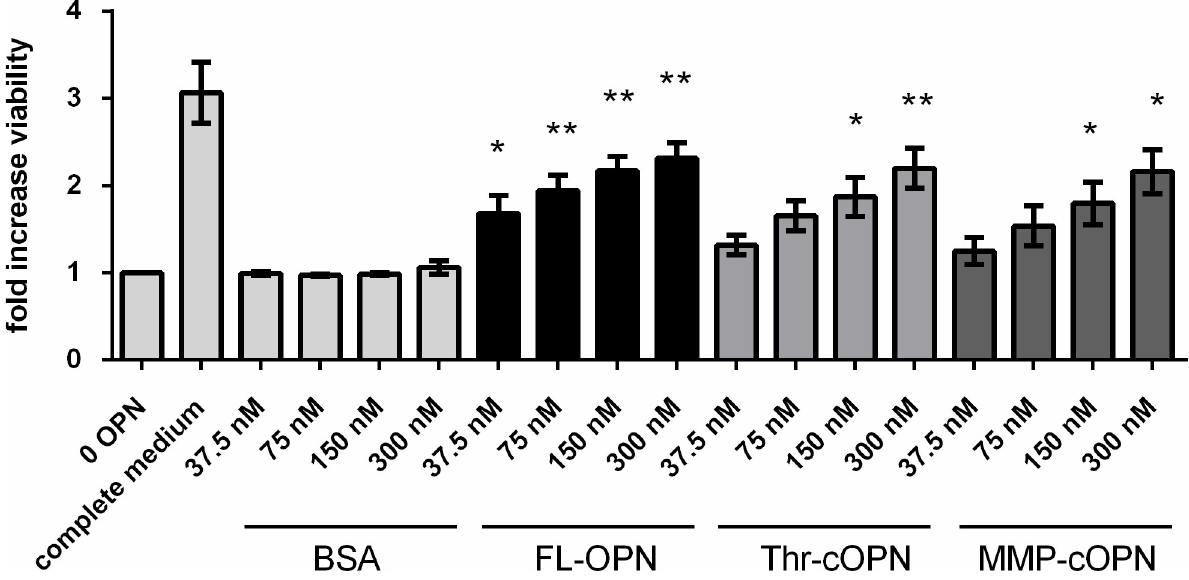
Data was calculated by normalizing to the values without OPN (negative control). Complete medium included 10% FCS; mean ± SEM depicted; Comparison of OPN treated groups with the respective BSA control; � p < 0.05, �� p < 0.01.